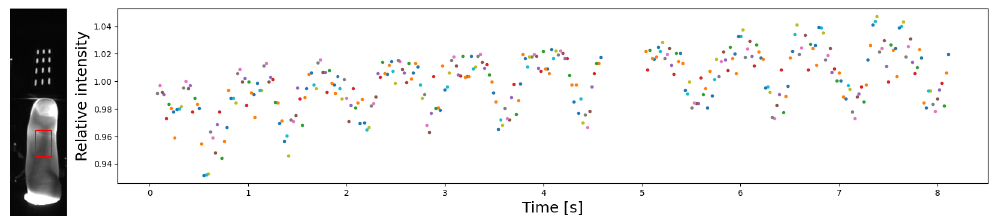
Figure 7. Sample pulse wave as obtained from combining intensity measurements for various NIR diodes. The image on the left shows a summed exposure with a red rectangle indicating the intensity measurement patch. Points colors correspond to the measurements with various NIR